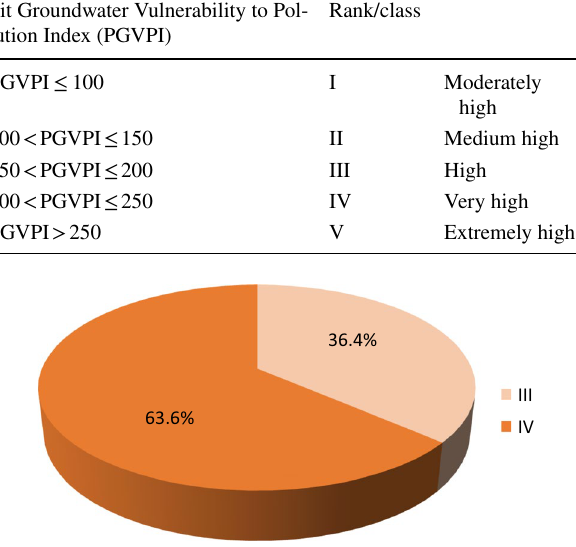
Fig. 6 Percentage of individual classes of groundwater